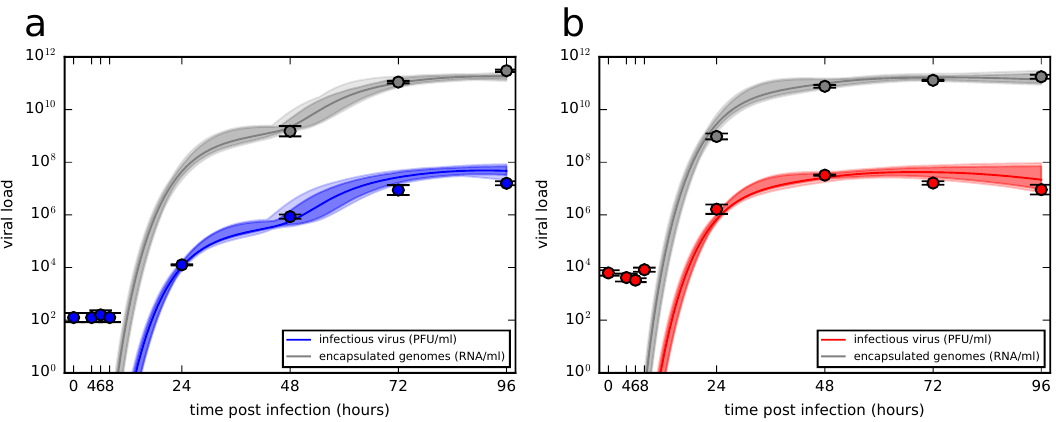
Figure 6. Time course of ZIKV infectious virus load and encapsulated genomes for ( a ) low (blue) and ( b ) high (red) MOI viral load data. Data are shown as the mean standard deviation. The best-fits are ± displayed as solid green lines. The light shading around the best-fits corresponds to the model kinetics associated with MCMC-accepted parameters. The dark shading represents 95% credible